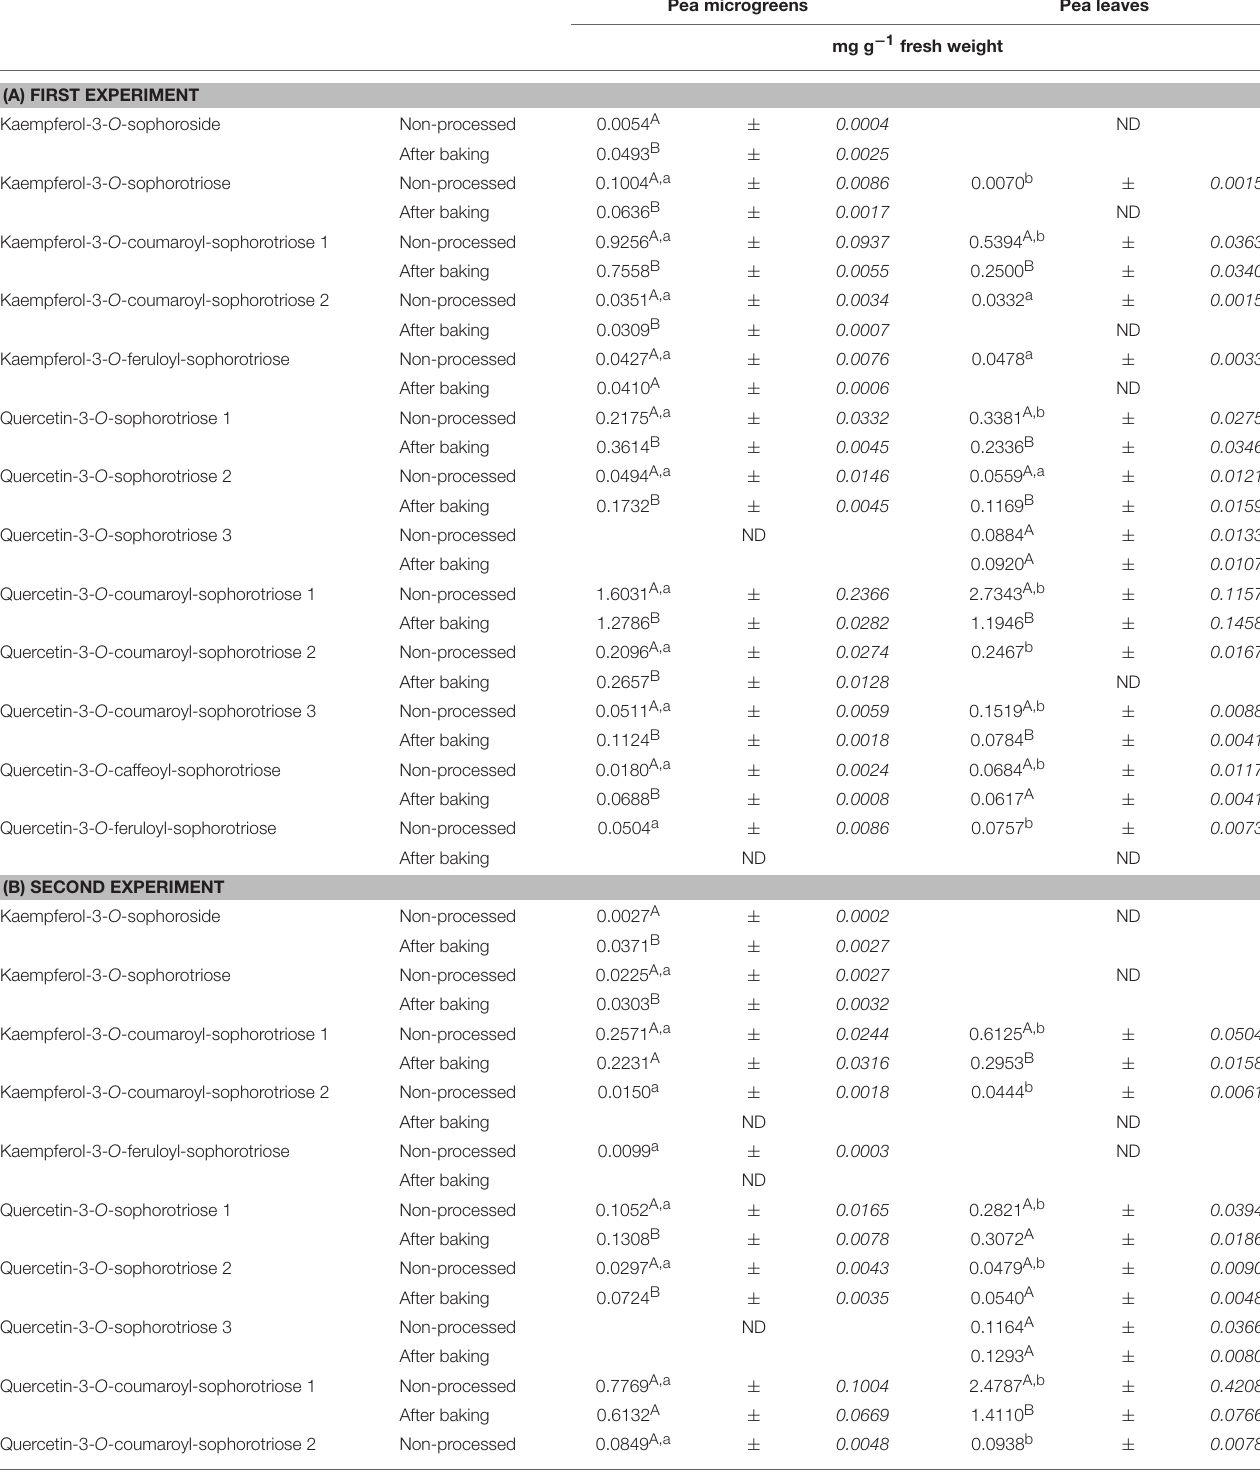
TABLE 1 | Average flavonoid concentration in pea microgreens (7 d) and pea leaves (14 d): Non-processed and in the pea-enriched